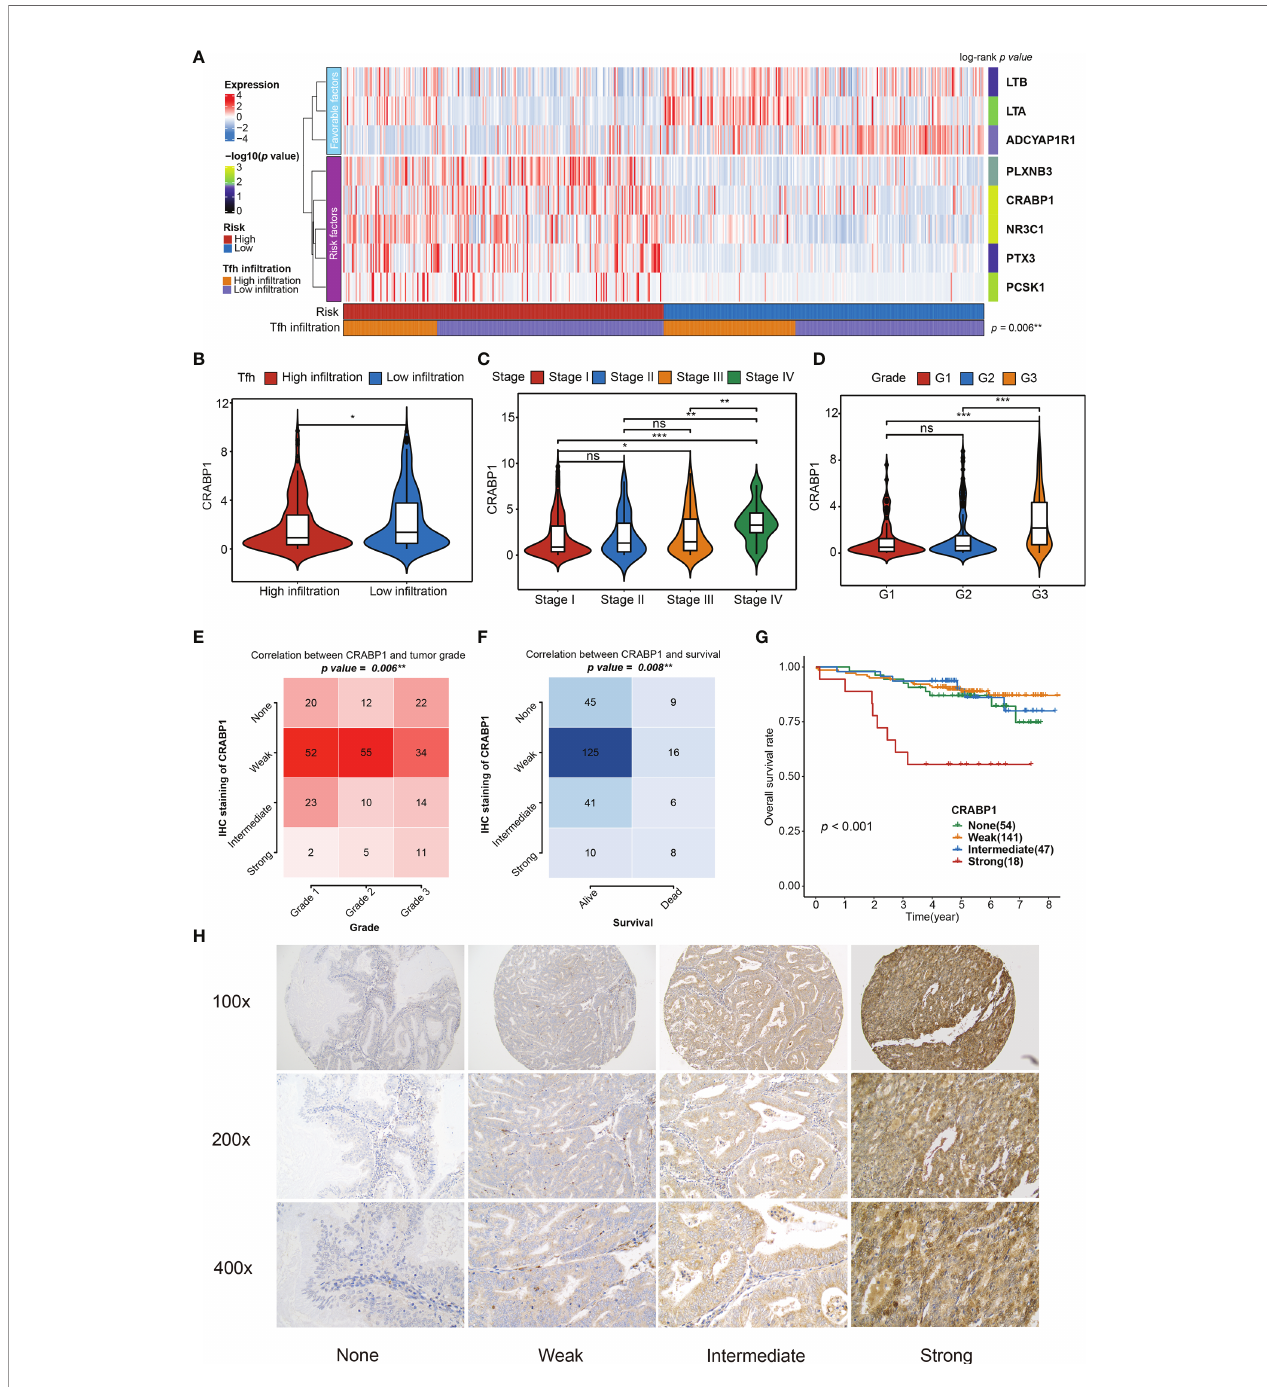
FIGURE 6 | Relationship between the signi fi cant genes in the TIRM and the clinical variables. (A) The abundances of eight signi fi cant immune-related genes (involved in TIRM) in high- and low-risk groups of 520 EC patients. Statistical differences in Tfh in fi ltration between the two high- and low-risk groups were compared using Fisher ’ s exact test. The log-rank p -values for the univariate Cox regression analysis are shown on the right side of the heatmap, indicated by the color gradient. ** p < 0.01. (B – D) Distribution of the CRABP1 expression in Tfh in fi ltration subtypes (high and low) (B) , stage (stage I, stage II, stage III, and stage IV) (C) , and grade (G1, G2, and G3) (D) . Middle line: median; box edges: 25th and 75th percentiles, whiskers: most extreme points. * p < 0.05, ** p < 0.01, *** p < 0.001, Wilcoxon rank- sum test and Kruskal – Wallis test. (E, F) The correlation between the grade (E) and survival status (F) and CRABP1 IHC staining in 260 EC tissues ( p = 0.006 and p = 0.008, respectively, Fisher ’ s exact test). (G) Kaplan – Meier curve of the overall survival for 260 EC patients with none, weak, intermediate, and strong CRABP1 IHC staining ( p < 0.001). (H) The CRABP1 immunoreactivity in none, weak, intermediate, and strong scoring at 100×, 200×, and 400× magni fi cations. ns, non signi fi